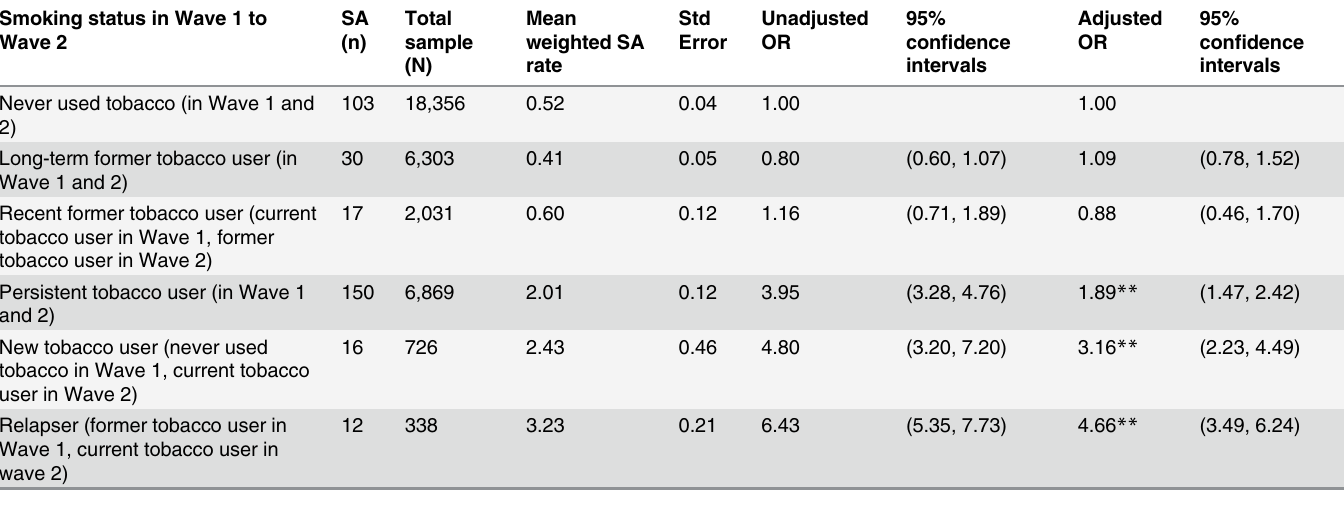
Table 2. Weighted Percentages, Standard Errors, Unadjusted and Adjusted Odds Ratios (OR) and 95% Confidence Intervals of Suicide Attempts (SA) Occurred Between Wave 1 and 2 (mean: 3.1 years) according to changes in smoking status during the same period. Smoking status in Wave 1 to Wave